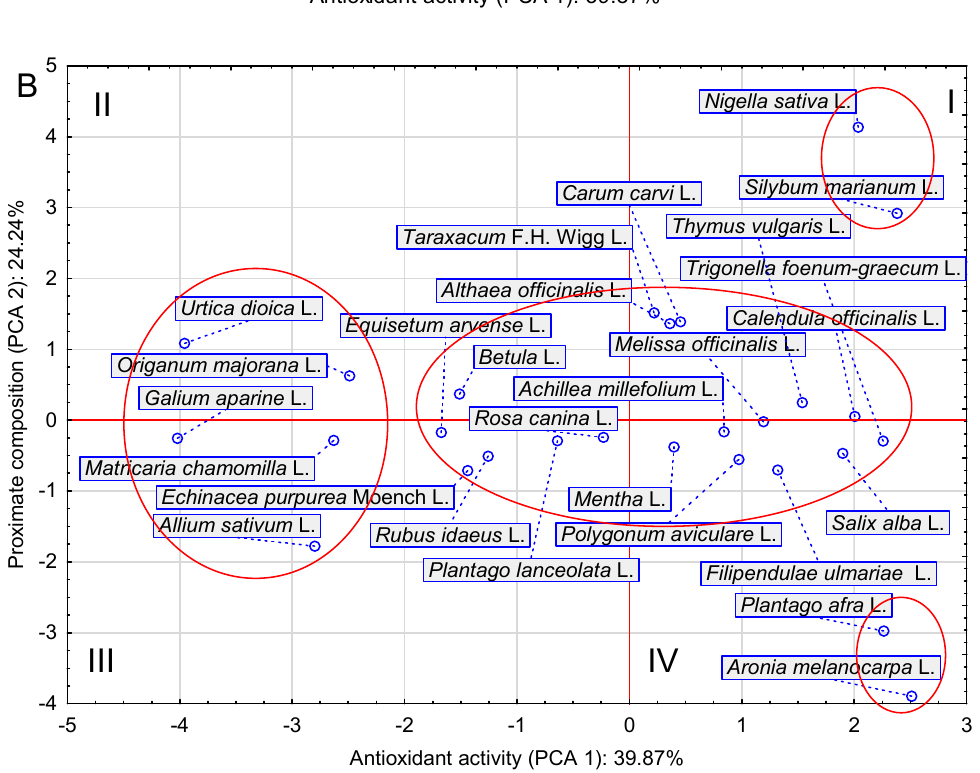
Figure 1. Biplot based on first two principal component axes for nutritional value and antioxidant activity ( A ) and distribution of 27 herbs on the first two components obtained from principal component analysis ( B ). Abbreviation crude protein (CP), crude fibre (CF), ether extract (EE), crude ash (CA), nitrogen free extract (NFE), 2,2 (cid:48) -azino-bis(3-ethylbenzothiazoline-6-sulfonic acid (ABTS • + radical), 2,2 (cid:48) -Diphenyl-1-picrylhydrazyl (DPPH • + ), ferric ion reducing antioxidant parameter